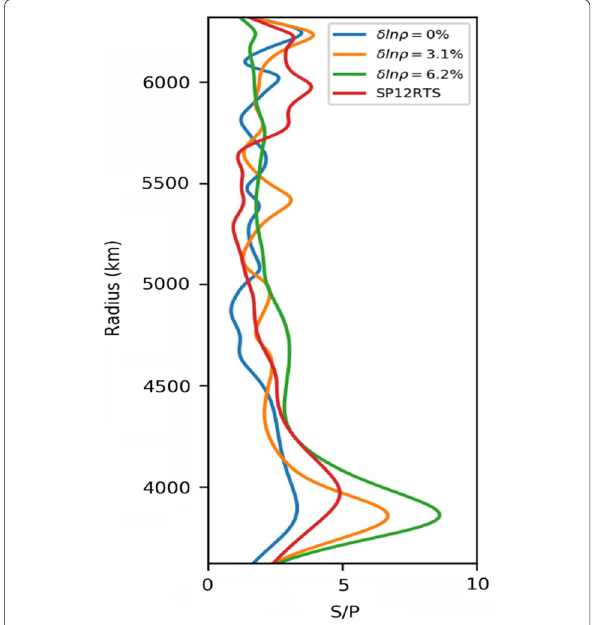
Fig. 10 S/P plotted against radius, where S/P is the ratio RMS δ lnV δ lnV s /RMS p . Model slices are taken along the same longitude as Pacific mantle segments in previous plots except they are centered at 15 ◦ latitude where P-wave coverage is